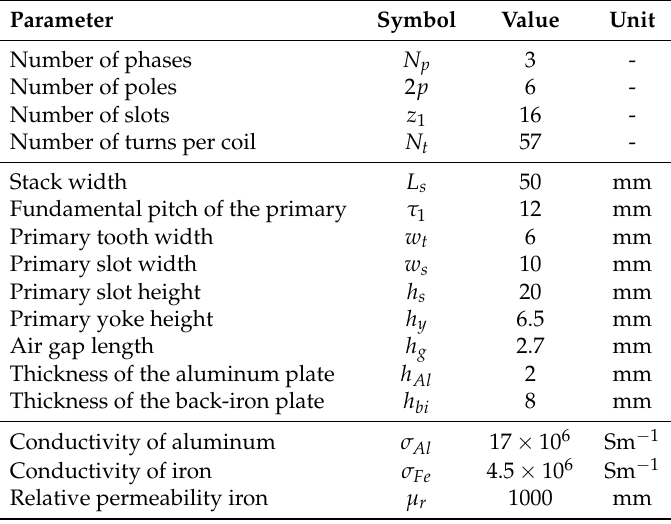
Table 1. Parameters of the double-layer single-sided